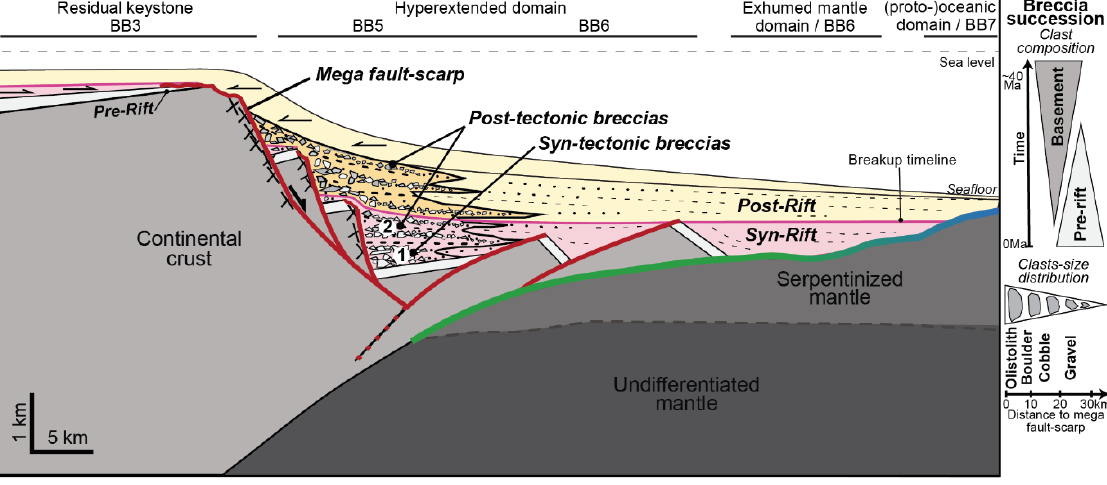
Figure 10. Schematic diagram summarizing the major structural and stratigraphic characteristics across a mega-fault scarp at distal magma-poor rifted margins (modified from [45]). Note the presence of syn- and post-rift mega-breccias at the toe of the fault scarp. In the present study, we interpret the Briançonnais s. str. units to have belonged to the distal high to the left of the figure, which represents a residual keystone/BB3; and we interpret the Prepiemonte units (including the so-called “Internal Briançonnais” of [126]) to have belonged to an extensional detachment system at a topographic low/BB5–BB6, as illustrated in the center of the figure. (1) syn-tectonic strata; (2) post-tectonic strata.